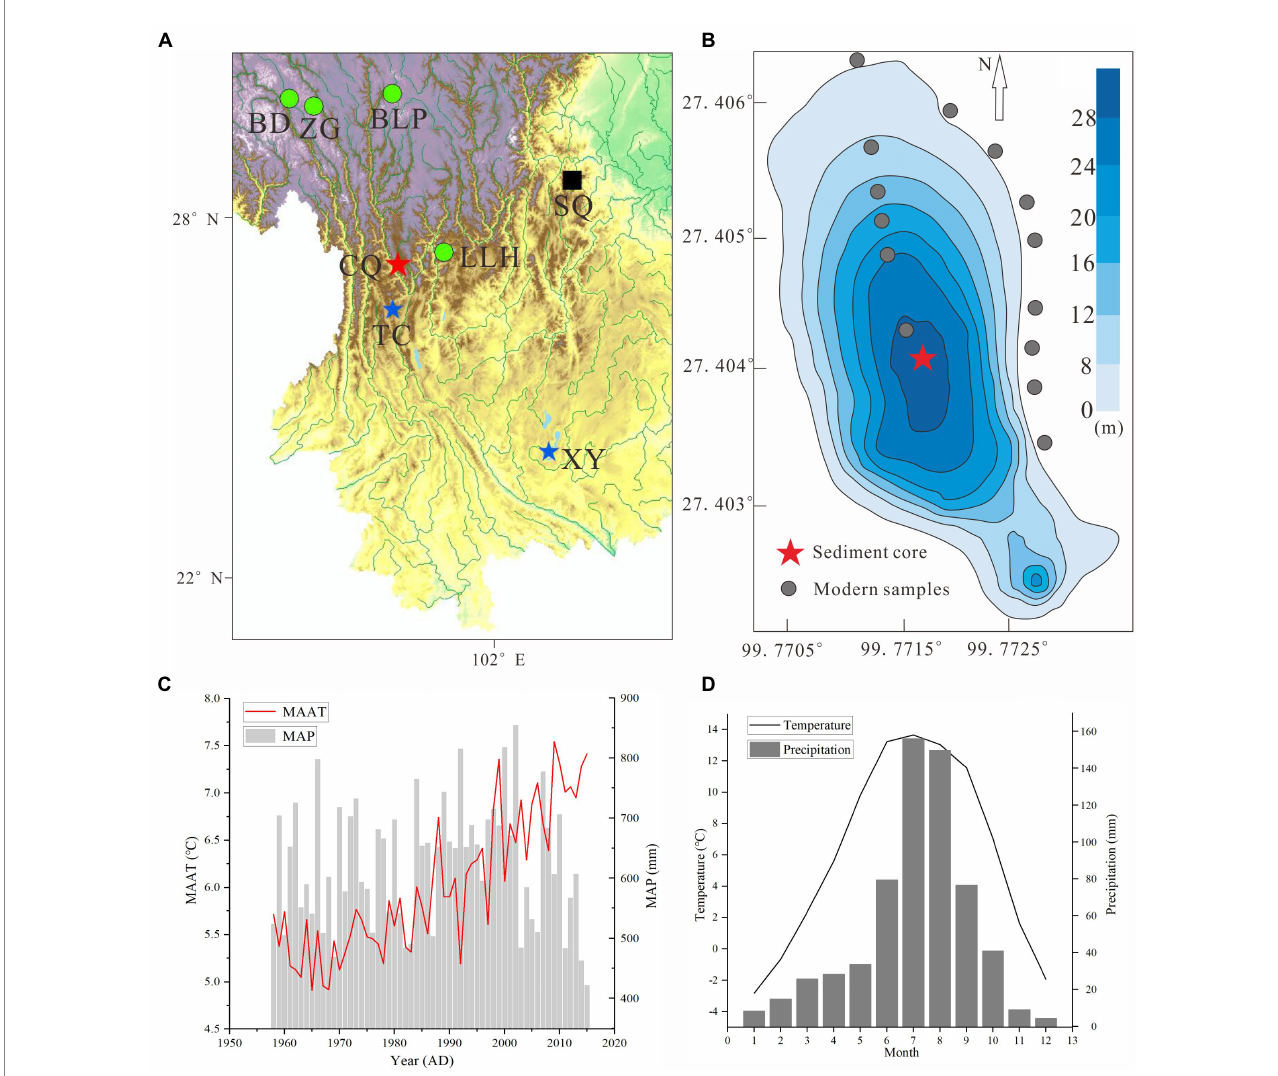
FIGURE 1 Location map and core sampling. (A) The map showing location of the Lake Cuoqia (CQ, red asterisks) and other paleoclimate records mentioned in this study. Blue asterisks are paleotemperature record from lakes [TC: Lake Tiancai (Zhang et al., 2017; Feng et al., 2019); XY: Lake Xingyun (Wu et al., 2018)]. Black block is stalagmite record from Shenqi cave (Tan et al., 2018). Green circle is tree ring records. [LLH: Larix trees in the low-latitude highlands (Xu et al., 2019); BLP: Batang-Litang Plateau (An et al., 2014); BD, ZG: Bangda and Zuogong (Duan and Zhang, 2014)]. (B) Bathymetry of the Lake Cuoqia and locations of the sediment cores (asterisks), surface sediment samples and soil samples on the catchment (grey dots). (C) The temperature and precipitation changes from Shangri La Meteorological Station during 1958–2015 years. (D) Mean monthly temperature and precipitation at the Shangri-la Meteorological Station, Yunnan Province, China (data retrieved from the Meteorological Administration of China, http://data.cma.cn/). (For interpretation of the references to color in this figure legend, the reader is referred to the web version of this